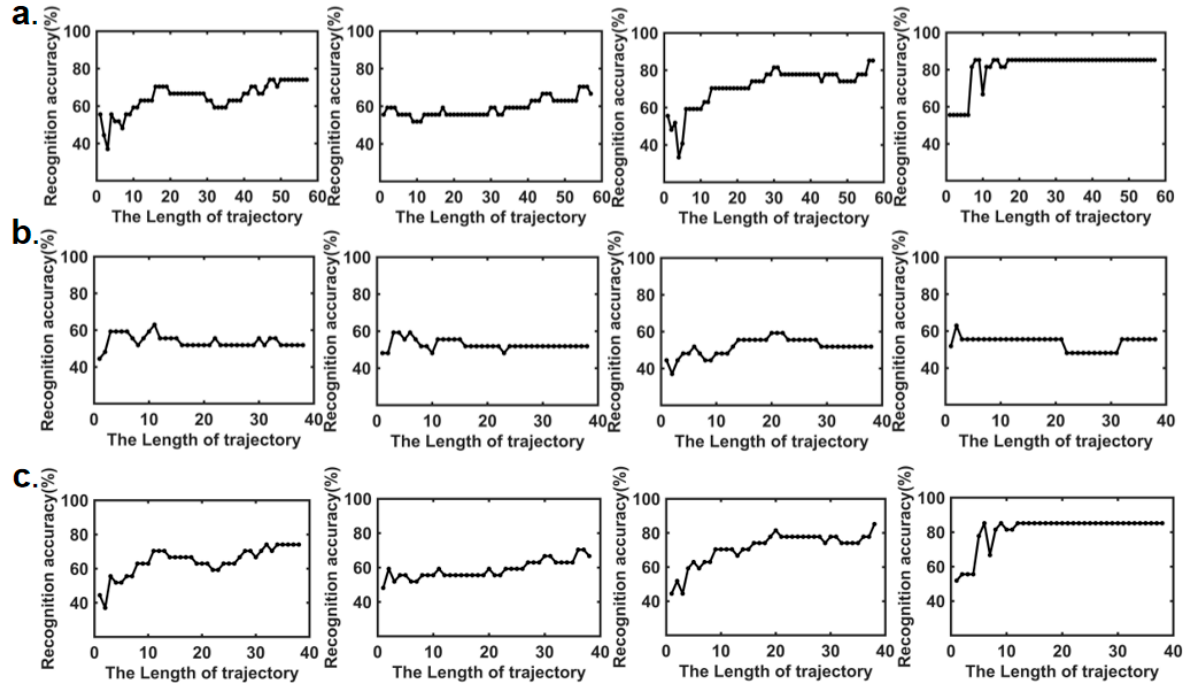
Figure 7. Prediction accuracy based on ( a ) time t and coordinates (x, y), ( b ) time t and distance D, and ( c ) time and height Y of different trajectory points with KNN, NB, LDA, and CART.